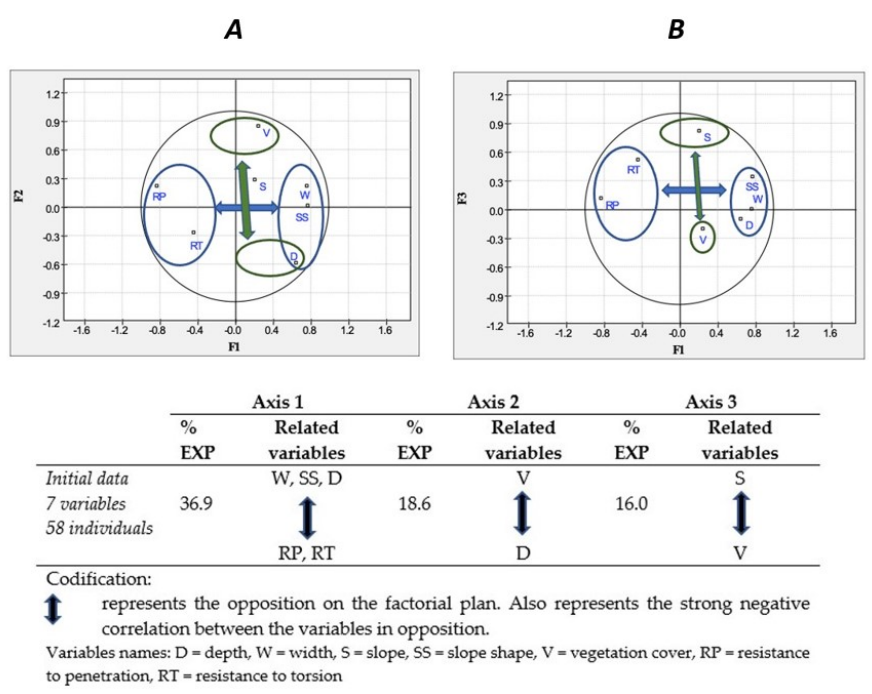
Figure 3. ACP output: main correlation between variables according to each factorial axis: ( A ) fac- torial axis F1 (explaining 36.9% of the variables’ variability) and factorial axis F2 (explaining 18.6% of the variables’ variability) and ( B ) factorial axis F1 and factorial axis F3 (explaining 16.0% of the variables’ variability).